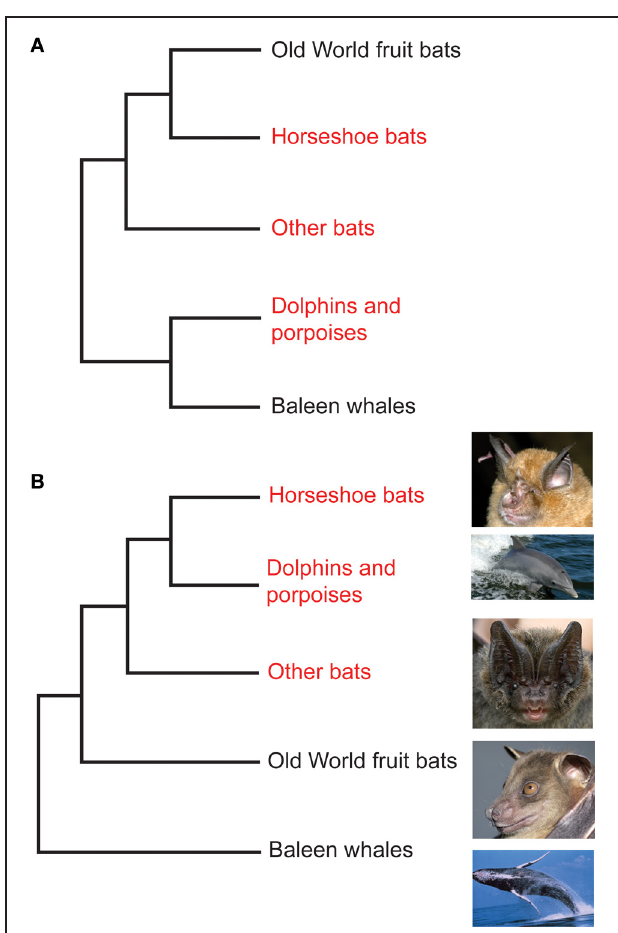
FIGURE 3 | Convergent evolution of prestin sequences in echolocating bats and cetaceans. (A) Phylogeny of Old World fruit bats (Pteropodidae), horseshoe bats and their close relatives, other bat lineages studied by Liu et al. (2010a,b) and Li et al. (2010), dolphins and porpoises, and baleen whales as determined from large-scale molecular sequence analyses. (B) The arrangement that arises from analysis of the Prestin gene. Bat groups highlighted in red use laryngeal echolocation and cetacean groups highlighted in red exhibit biosonar behavior. In (A) these echolocating taxa are paraphyletic—non-echolocating Old World fruit bats are sister to echolocating horseshoe bats, and echolocating dolphins and porpoises are sister to non-echolocating baleen whales. In (B) all echolocating taxa form a monophyletic group, and dolphins and porpoises are the sister group of horseshoe bats. Photographs are species studied by Liu et al. (2010a,b) and Li et al. (2010). From top to bottom they are the greater horseshoe bat Rhinolophus ferrumequinum (G. Jones), the bottlenose dolphin Tursiops truncatus (NASA), the Beijing barbastelle Barbastella beijingensis (J. R. Flanders), the greater short-nosed fruit bat Cynopterus sphinx (G. Jones), and the humpback whale Megaptera novaeangliae (NOAA). From Jones (2010) reproduced with permission from